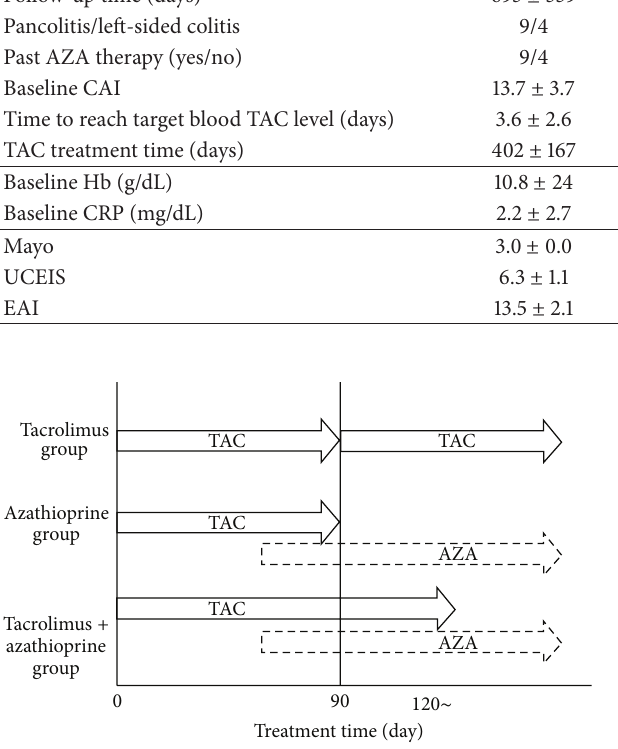
Figure 2: Duration of tacrolimus (TAC) therapy in the subgroups who received tacrolimus, azathioprine (AZA), or tacrolimus + AZA as maintenance